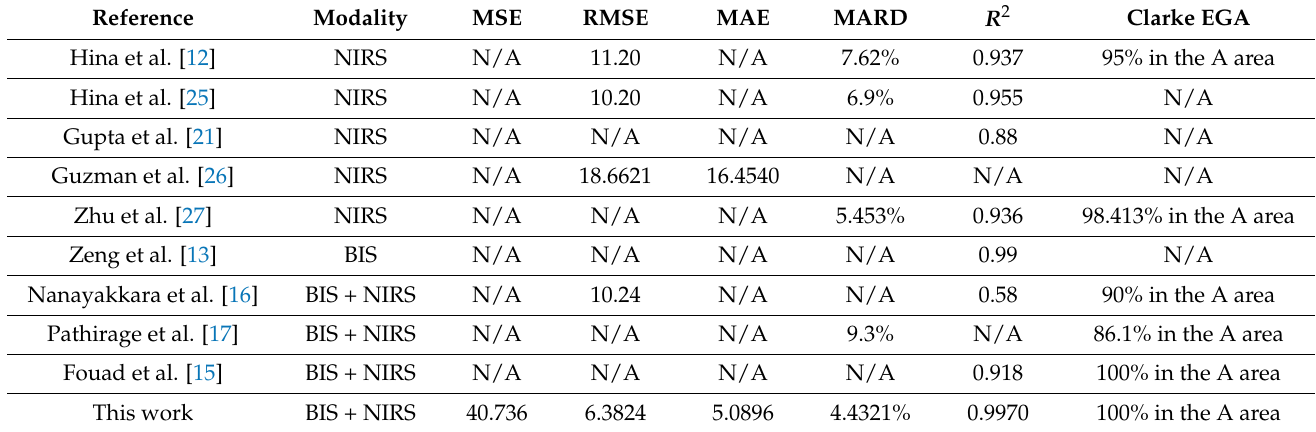
Table 3. Comparison of noninvasive blood glucose assessment